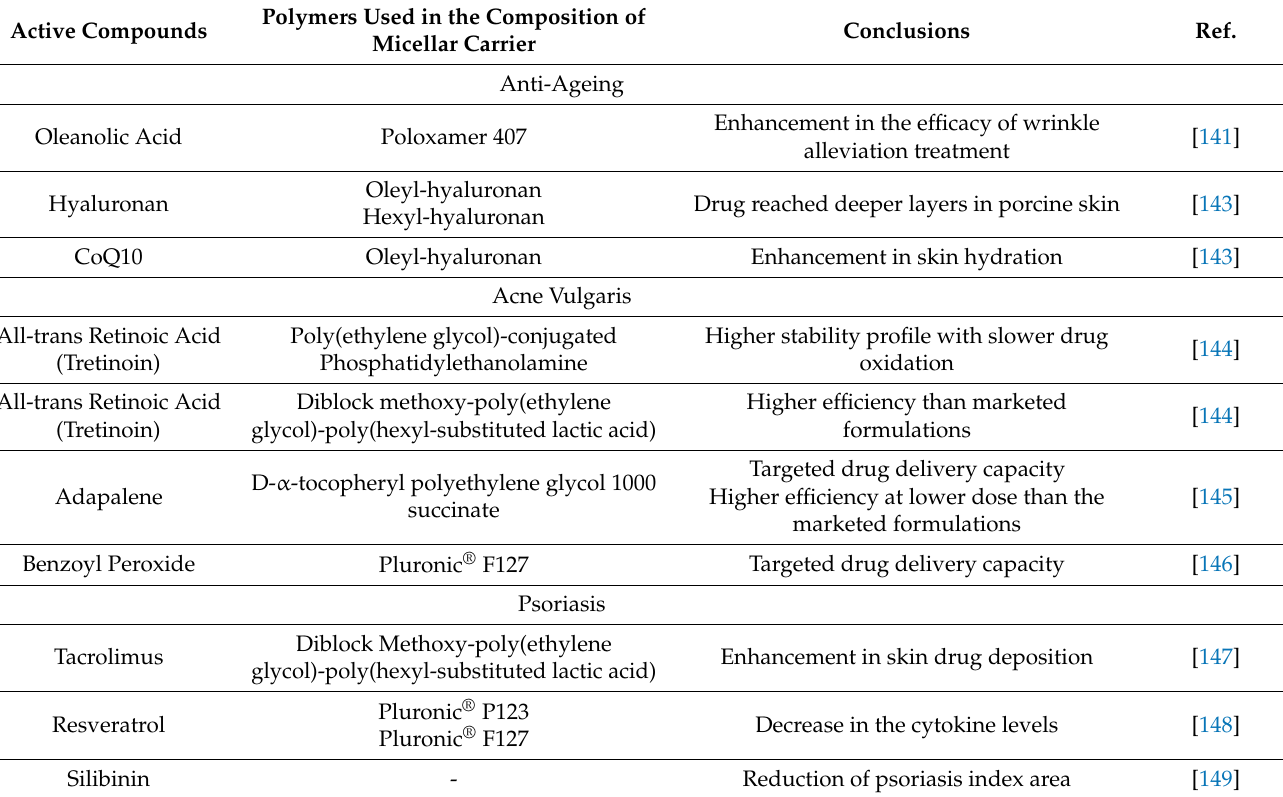
Table 3. Summary of the polymeric micelles used for skin delivery described in the literature during the past decade. Reprinted from [139] under a CC BY license.